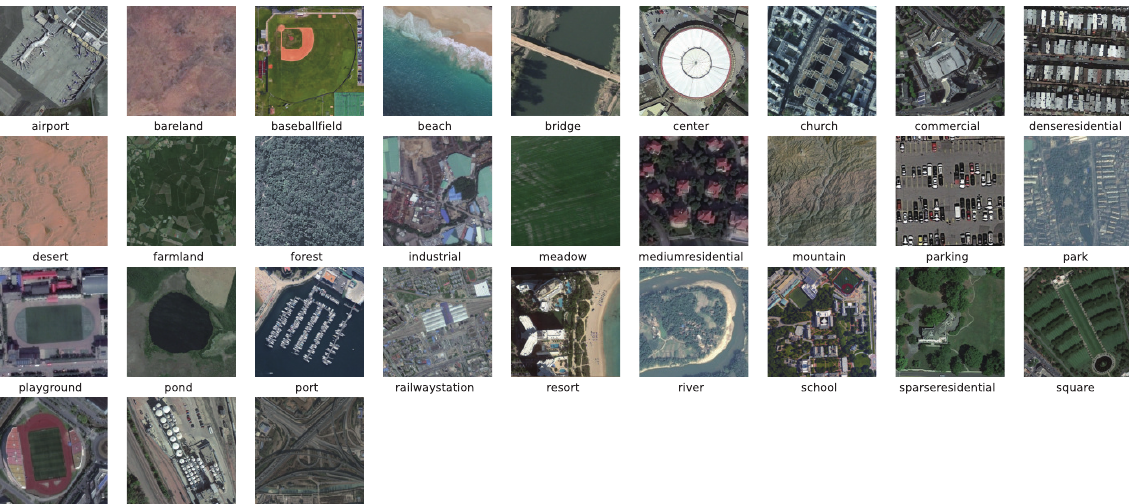
Figure 8. Some samples from the AID dataset.